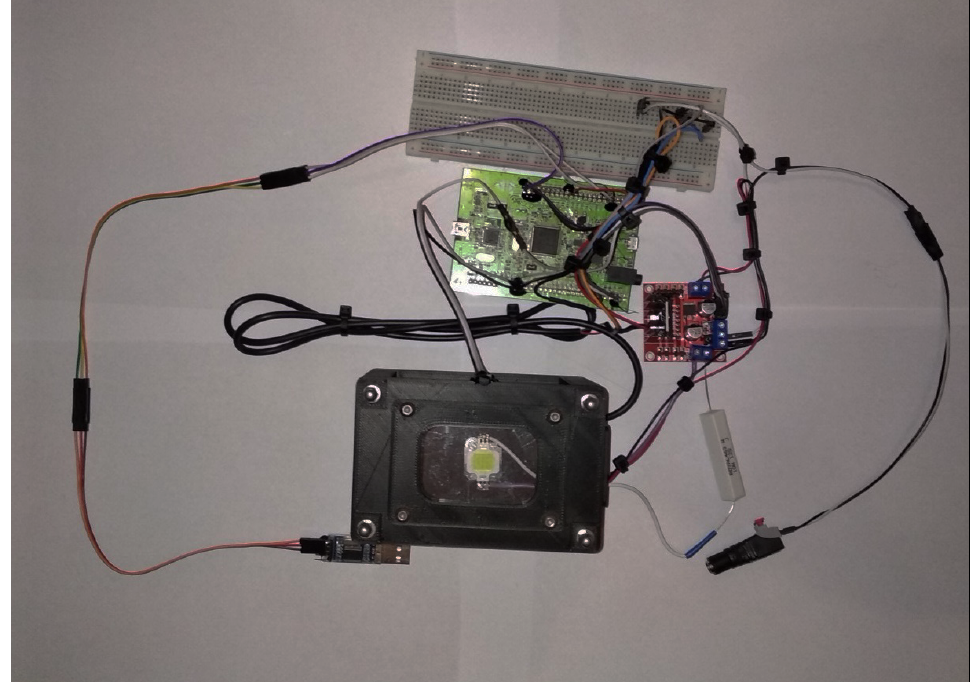
Figure 4. Complete set of platform elements (placed in the case): STM32F4 evaluation board and peripherals such as two thermometers, light-emitting diode (LED), fan, and